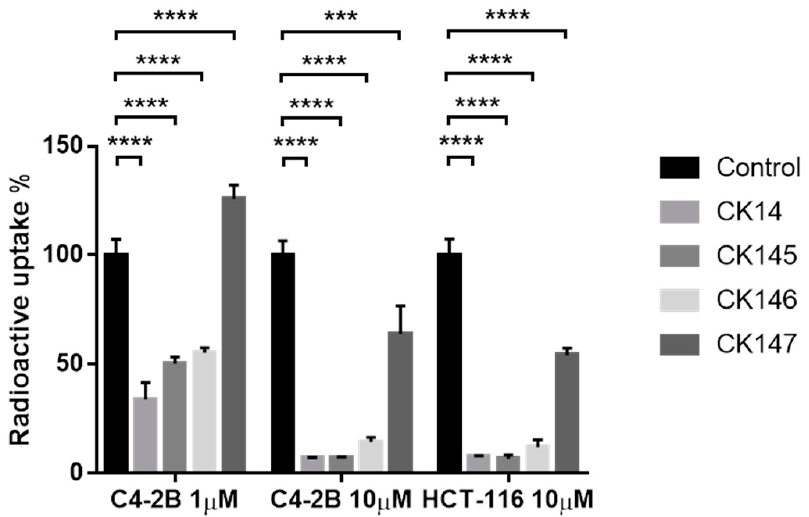
Figure 8. Uptake % of [ 18 F]D4-FCH (0.74 MBq) in C4-2B and HCT-116 cells following 1-h incubation in the absence (Control; DMSO) or presence of CHKA inhibitors at 1 or 10 µ M ( n = 6; mean ± SD); p values via unpaired two-tailed t -test: *** p = 0.0001, **** p < 0.0001.